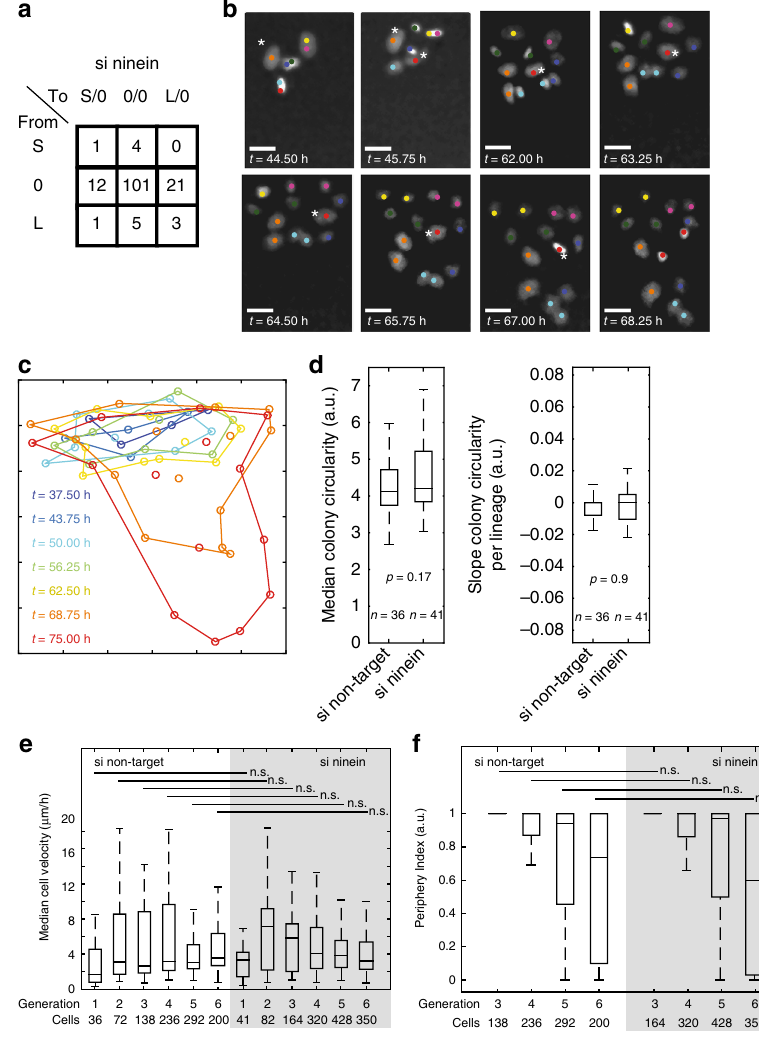
Fig. 4 Biological controls for the non-stochasticity in the propagation of variability of cell cycle duration in si non-target MDCK. a Representation of the results of the propagation test for MDCK si ninein (as Fig. 3f). b Cell positions in the forming colony at selected time points of the si non-target lineage presented in Fig. 1a including colour code. Asterisks mark L-cells (orange and red labelled nuclei). Bar 5 µ m. c Illustration of the cell colony shape in b based on the position of the nuclear centroids at seven time points (superimposed and colour-coded). Analogous circumference lines are the basis for determining the colony circularity and periphery indices. d Approximation of the gross colony shape and its change over time in colonies of si non-target and si ninein cells. Boxplot: central mark — median; edges of horizontal box — fi rst and third quartiles; whiskers — 1.5 times IQR. n number of colonies analysed. Left: comparison of median circularities for each colony during its imaging time. (KW test, p -value) Right: to document the gross change of colony shapes over time per condition, the circularity for each colony was fi tted to a linear model as a function of time (robust linear regression was used to compute slopes. Comparison of slope distributions was tested according to Kruskal – Wallis ( p -value)). e The median cell velocities change over generations per siRNA-treated condition but are not different between si non-target and si ninein cells of the same generation. Data of si ninein cells on grey background. Boxplot as in d . f The periphery index, expressing the ratio of peripheral vs. central colony position of each cell during its lifetime, changes over generations but is not different between si non-target and si ninein cells. Data of si ninein cells on grey background. Boxplot as in d ; n.s., not signi fi cant at the signi fi cance level of outstanding frequency of the 3:L motif, (ii) increased the specialisation events occurring in cellular diversi fi cation pro- improbable frequency of the 3:S motif and (iii) erased the pro- cesses. At pH 6, an external stress to E. coli cells, but not at pH pagation of cell cycle duration variability that is present in si non- 7.5, non-stochastic propagation was detectable (Fig. 5b). This target MDCK cells, suggesting ninein to be involved in generating suggests that the tested cell classes (L-, S-, 0-cells) are linked to a cell cycle duration diversity in si non-target MDCK (Figs. 2c, 3, stress response possibly allowing individual members of the 4a, 5a). However, E. coli does not express ninein but can pro- population to cell-autonomously regulate the cell cycle duration pagate outlying cell cycle durations at non-stochastic levels, of their progeny to support the survival of the species. This seems suggesting that the molecular causes for the 3:1 motif differ. to be achieved by an increase of 0 to 0/0 and reduction of 0 to 0/S The non-stochastic propagation of cell cycle duration varia- divisions. We identi fi ed in C. elegans lineages the germline pre- bility (i.e., a non-stochastic propagation matrix composed of cursor cells as L-cells (Fig. 5f). These cells are prospective founder relative outlier cells) could represent a useful reporter for cell cells of new organisms, documenting their high division and fate